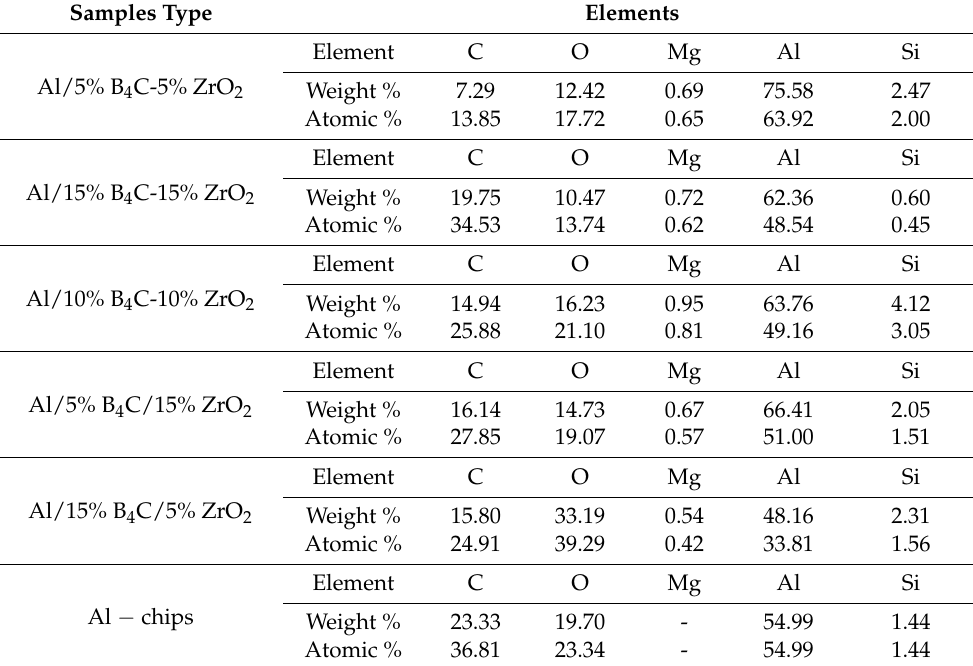
Table 7. Detailed EDS elements analysis of the investigated samples.